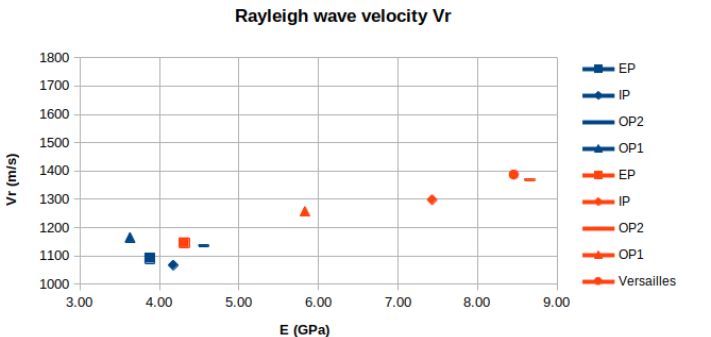
Figure 5. Rayleigh wave velocity as a function of Young’s modulus. Pure (blue) and composite (red)